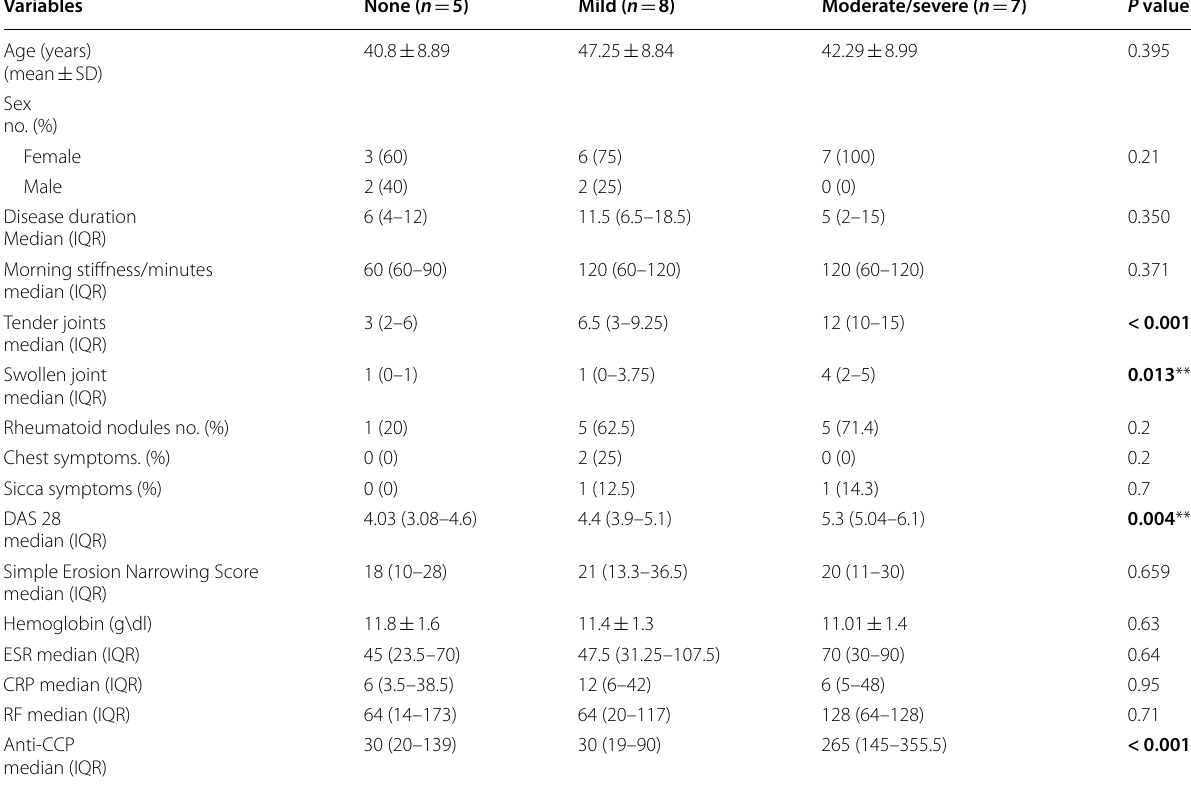
Table 3 Comparisons of the mean The Athens Insomnia Scale grading regarding the different disease parameters among the studied RA